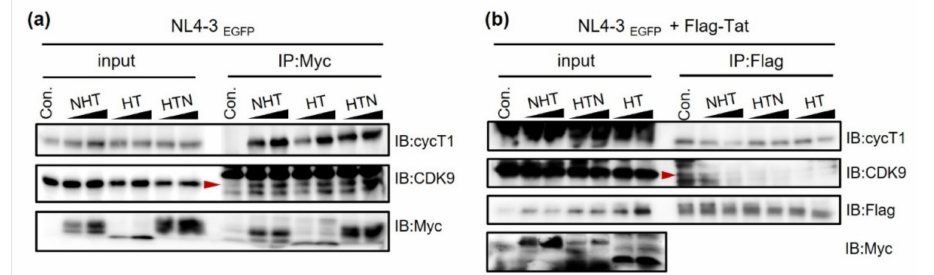
Figure 4. NHT, HTN, and HT interact with the transcriptional machinery. HEK293T cells were co-transfected with Myc-tagged NHT, HTN, or HT and NL4-3EGFP with or without Flag-Tat. Twenty- four hours after transfection, cells were lysed in passive lysis buffer. ( a ) The interactions of Myc-tagged chimeric proteins with the P-TEFb components CycT1 and CDK9. Each Myc-tagged protein in the cell lysate was pulled down by Myc antibody, and the interaction with P-TEFb was verified. ( b ) The interactions of the Flag-Tat with CycT1 and CDK9. The overexpressed Flag-Tat in the cell lysate was pulled down by Flag antibody, and its interaction with P-TEFb was verified. The red arrows indicate the CDK9